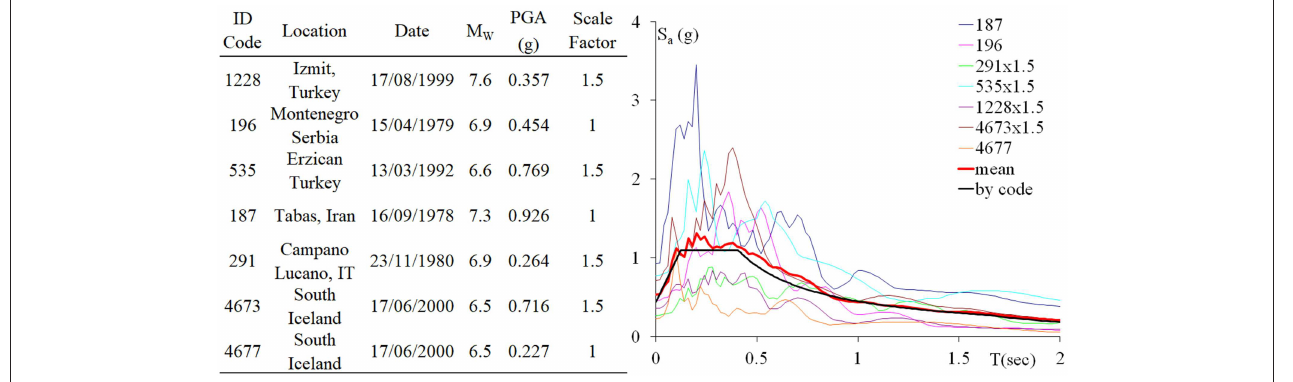
FIGURE 5 | Main characteristics of selected